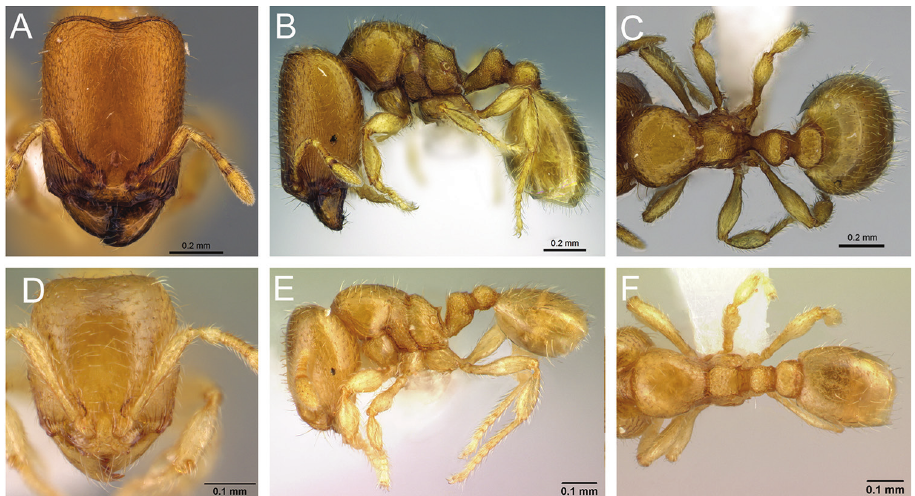
Figure 33. Carebara berivelo –holotype. Major worker, CASENT0438188. A head in full-face view B body in profile view C body in dorsal view. Minor worker, CASEN0438184 D head in full-face view E body in profile view F body in dorsal